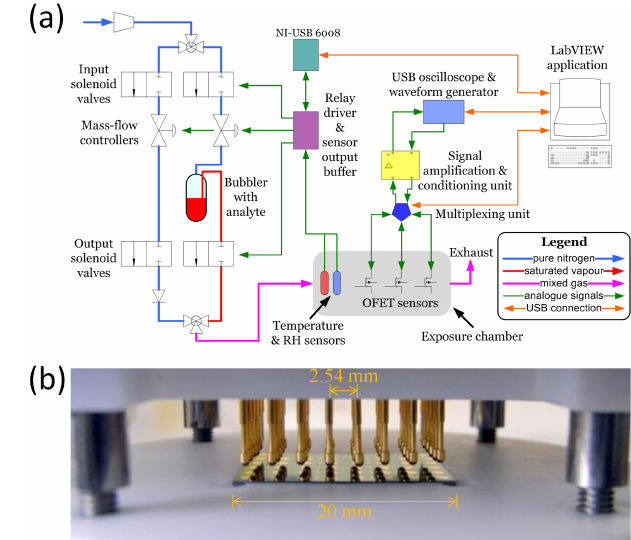
Figure 2. (a) Schematic representation of the computer-controlled pneumatic analyte odour delivery system, and multiplexed electri- cal OTFT drive and measurement system. (b) Array of 40 spring- loaded Au contact pins, matching the S/D contacts for the 20 OTFTs on the OTFT substrate below, shortly before making con- tact inside the exposure